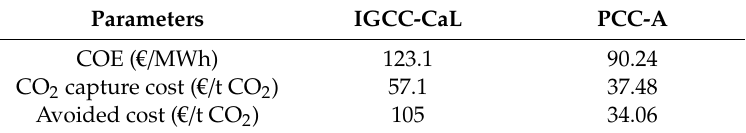
Table 10. Results of cost of electricity (COE), CO 2 capture cost, and avoided CO 2